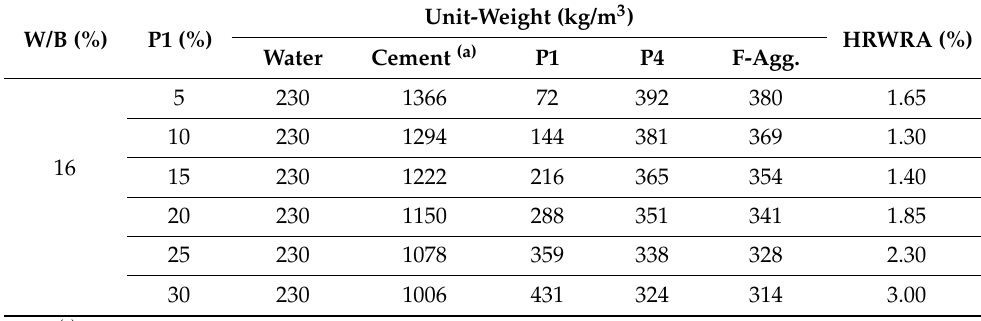
Table 6. Mixture proportions of base mortar (a test for replacement ratios by P1 and P4 ).